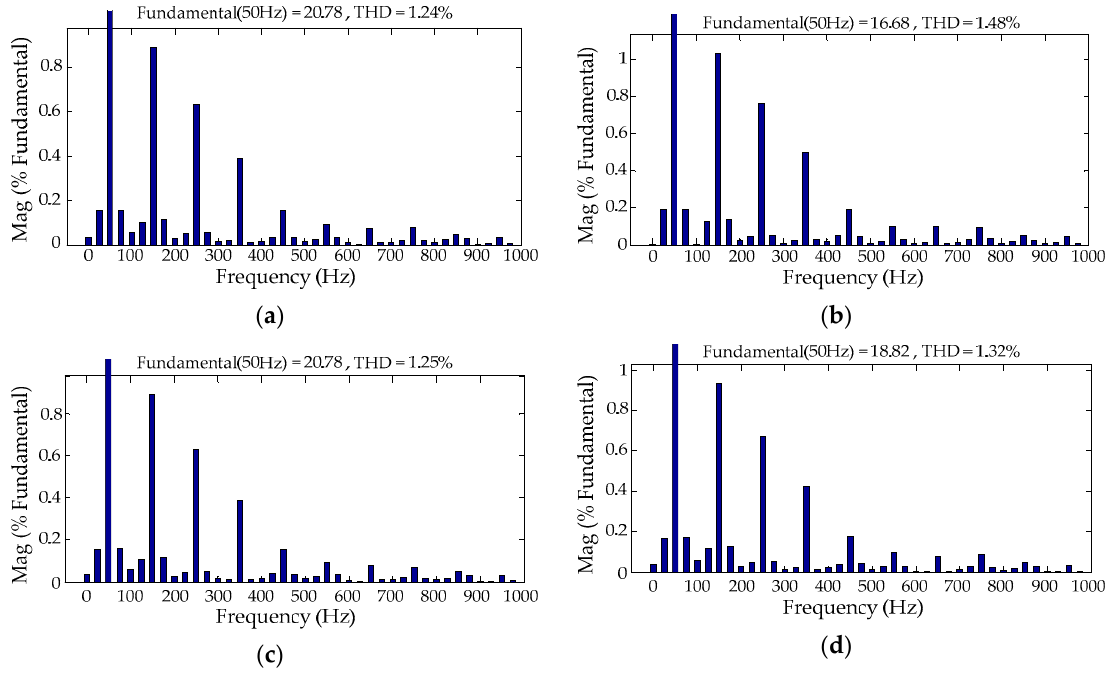
Figure 27. The harmonic spectrum results of power quality improvement under decentralized control and centralized control ( a ) stage 2 in decentralized control; ( b ) stage 3 in decentralized control; ( c ) stage 2 in centralized control; ( d ) stage 3 in centralized control. THD: total harmonic distortions.